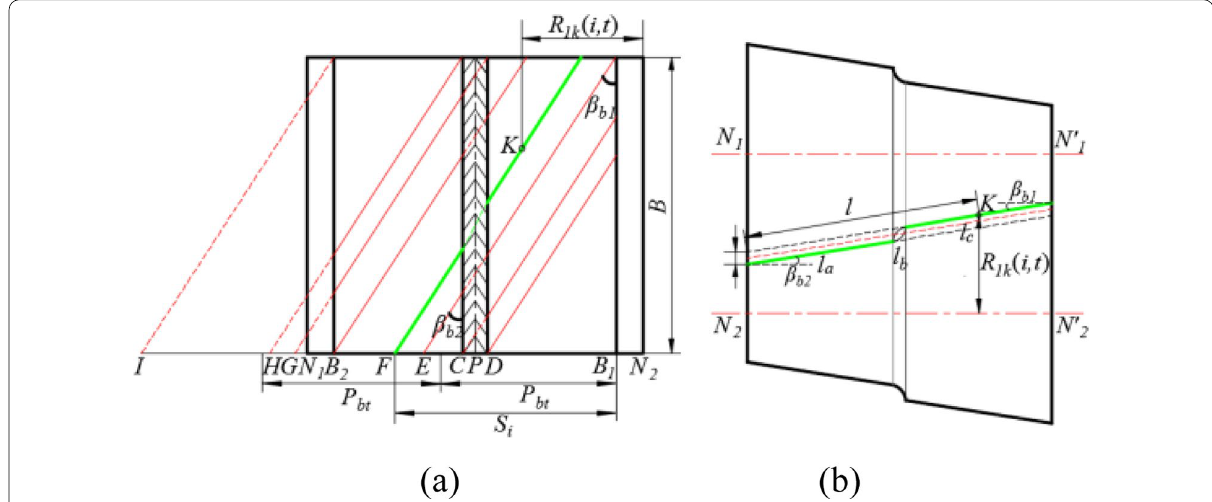
Figure 4 Contact line expansion on base cylinder when ε α > ε